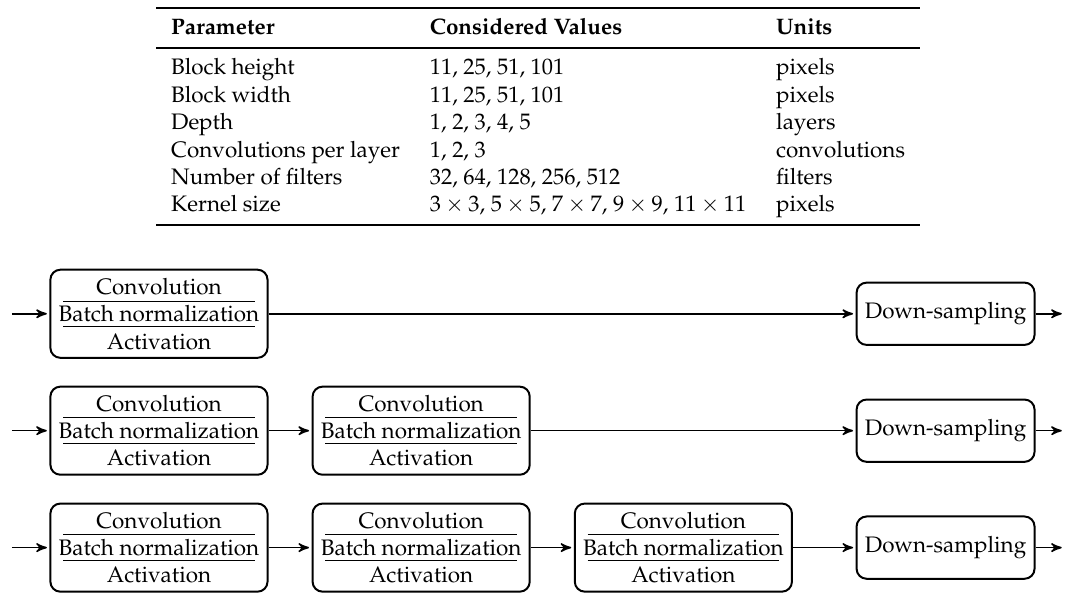
Table 2. Set of parameters considered in regard to the CNN configuration.